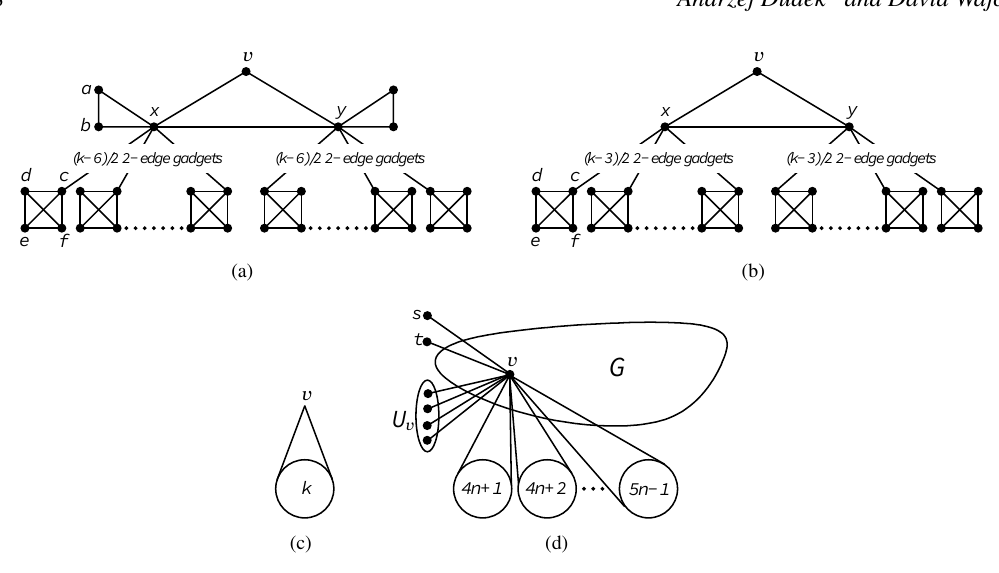
Fig. 2: A k -disallowing gadget (a) for even k , (b) for odd k and their symbolic representation (c); a construction of f ( G ) ,